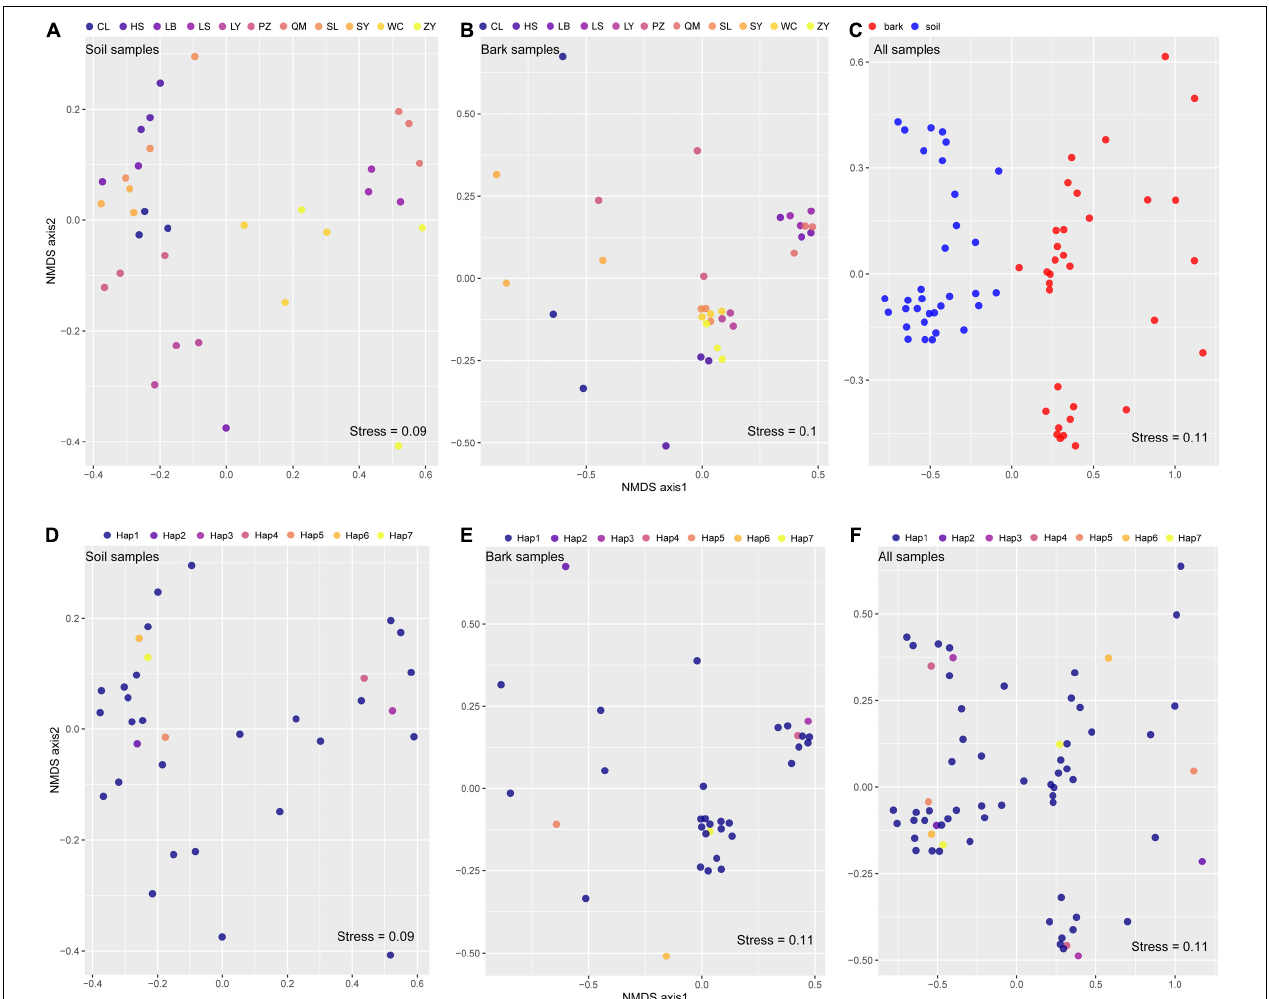
FIGURE 1 | Microbiome assembly was shaped more strongly by environmental conditions than by host niches or genotypes of E. ulmoides . Nonmetric multidimensional scaling (NMDS) ordinations based on weighted UniFrac distances matrices of bacterial communities for: (A) rhizosphere soil ( n = 33); (B) bark ( n = 33); (C) all samples of different niches ( n = 66); (D) soil samples of different genotypes ( n = 33); (E) bark samples of different genotypes ( n = 33); (F) all samples of different genotypes ( n =